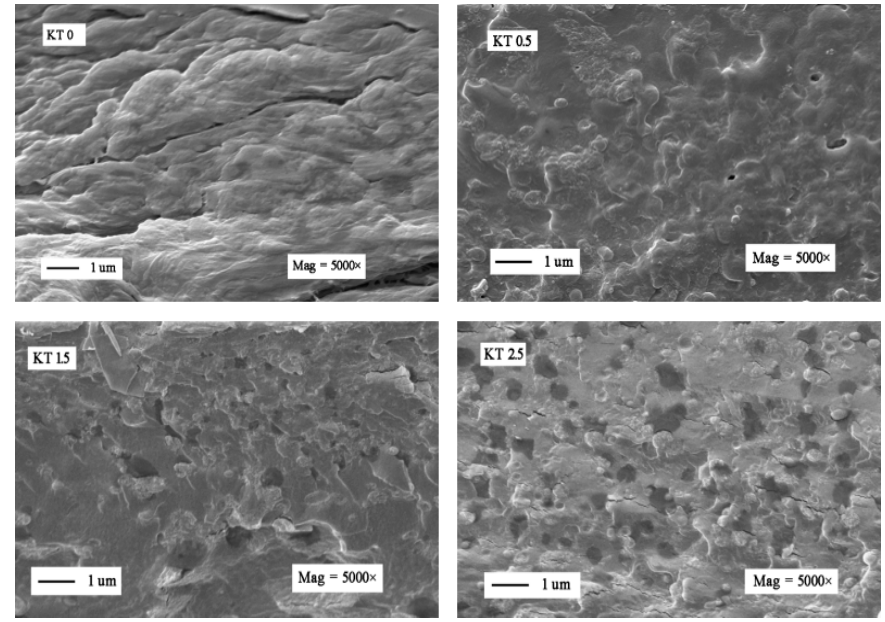
Figure 10. Cross-sectional SEM images of the composite films (KT0, KT0.5, KT1.5, and KT2.5).